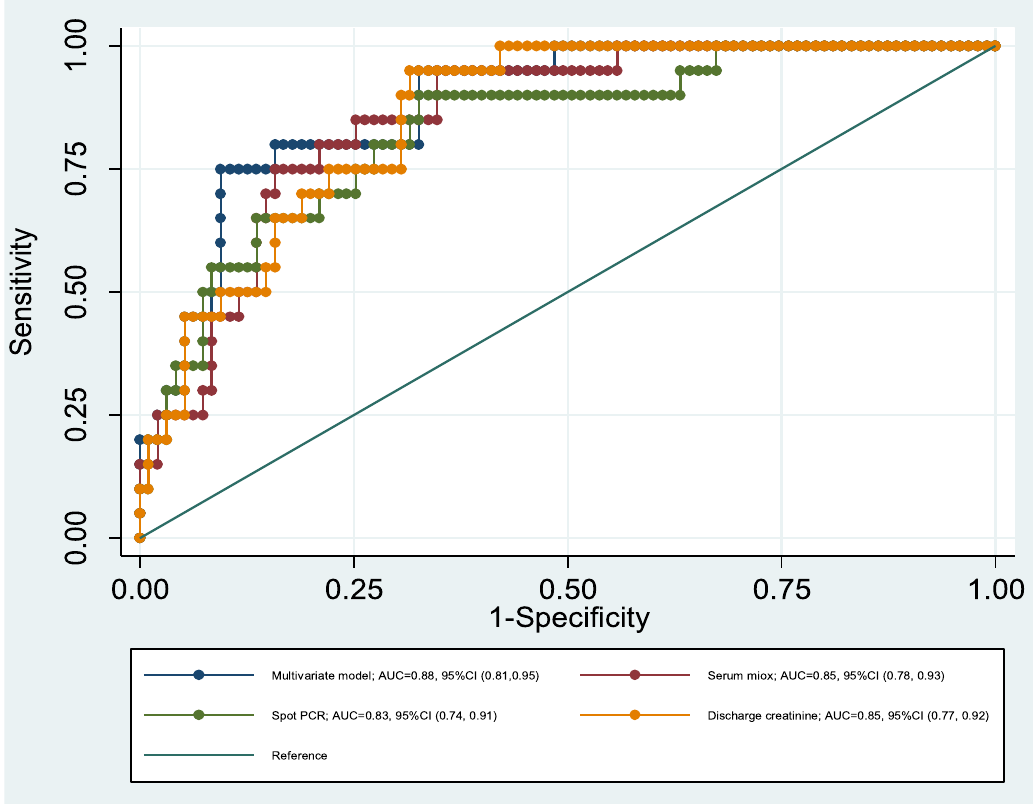
Figure 3. Receiver operating characteristic curves (ROC) for the multivariate model and its individual constituents. AUC area under the